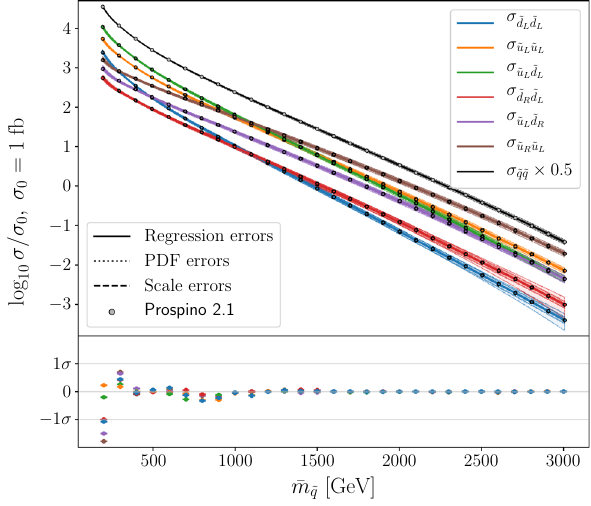
(colours) and the (rescaled) total cross-section for first and second- generation squark–squark production